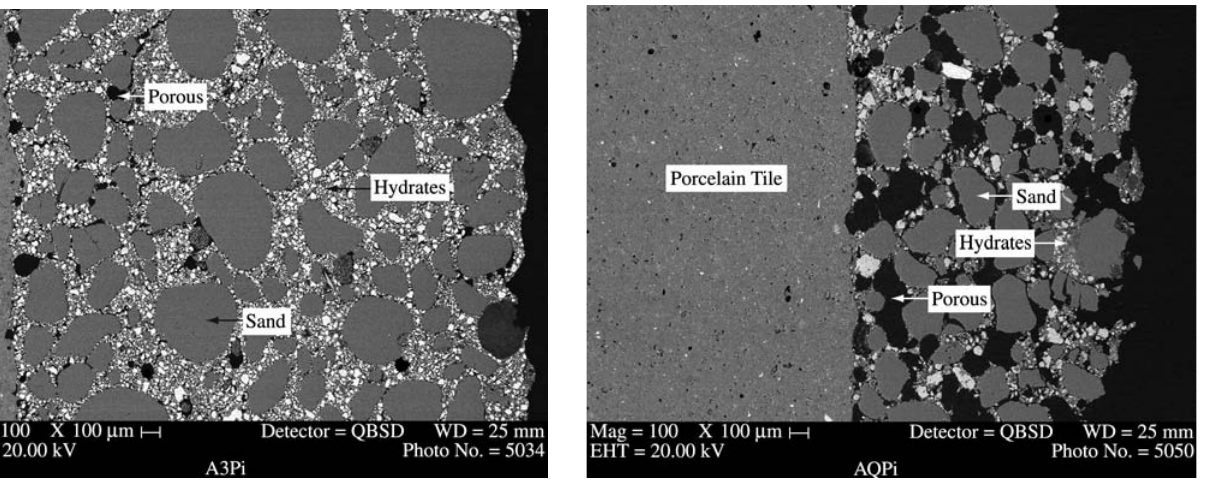
Figure 7. Backscattered electron micrograph of the polished surface. showing the interface between porcelain tile and commercial mortar.